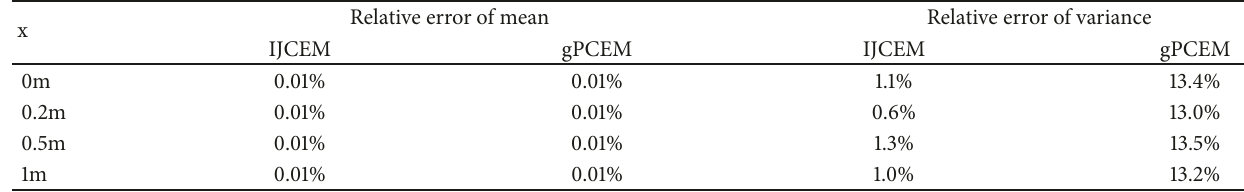
Figure 5: Mean and variance of the sound pressure’s imaginary parts of acoustic tube along the central axis at f=300Hz: (a) mean and (b) variance. Table 2: Relative error of mean and variance of the sound pressure’s imaginary parts.